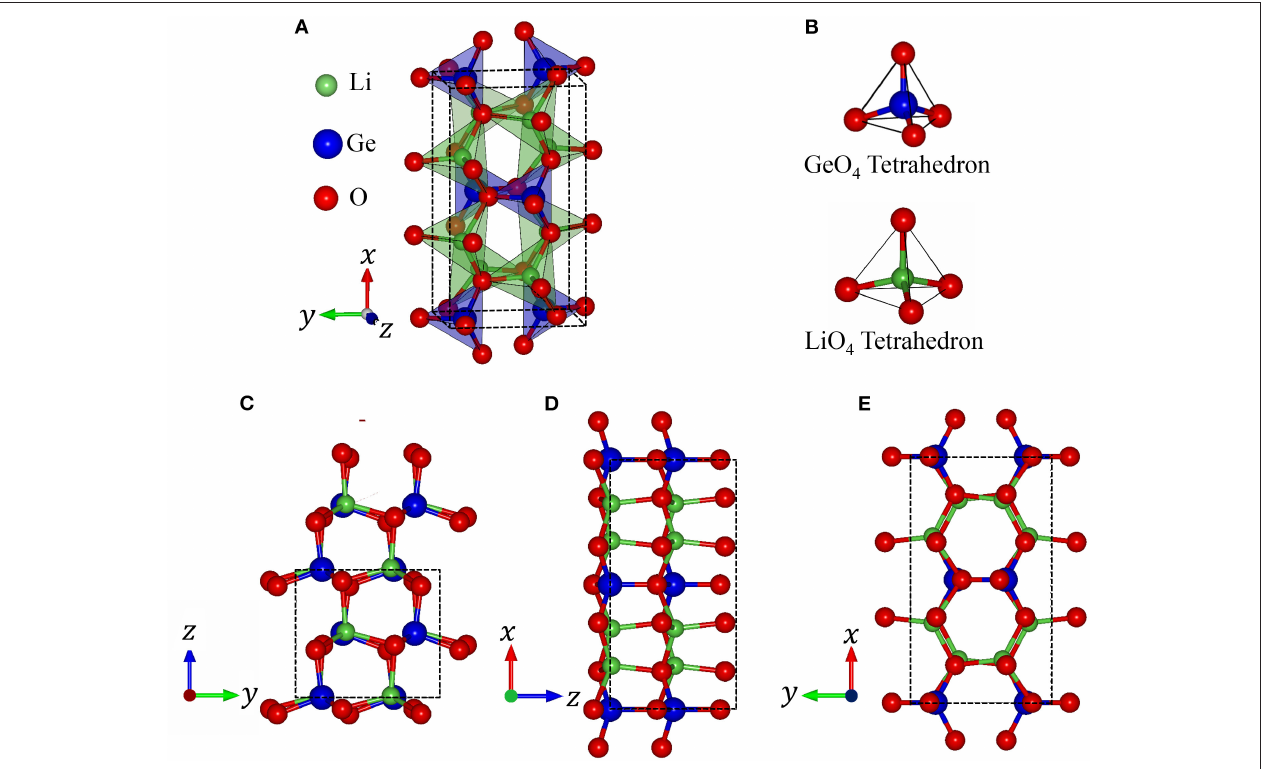
FIGURE 1 | (A) Polyhedron structure of Li 2 GeO 3 , (B) Oxygen (O) coordination around the Lithium (Li), Germanium (Ge) atoms. The geometric structure of Li 2 GeO 3 along the different projections (C) (100), (D) (010), and (E) (001).